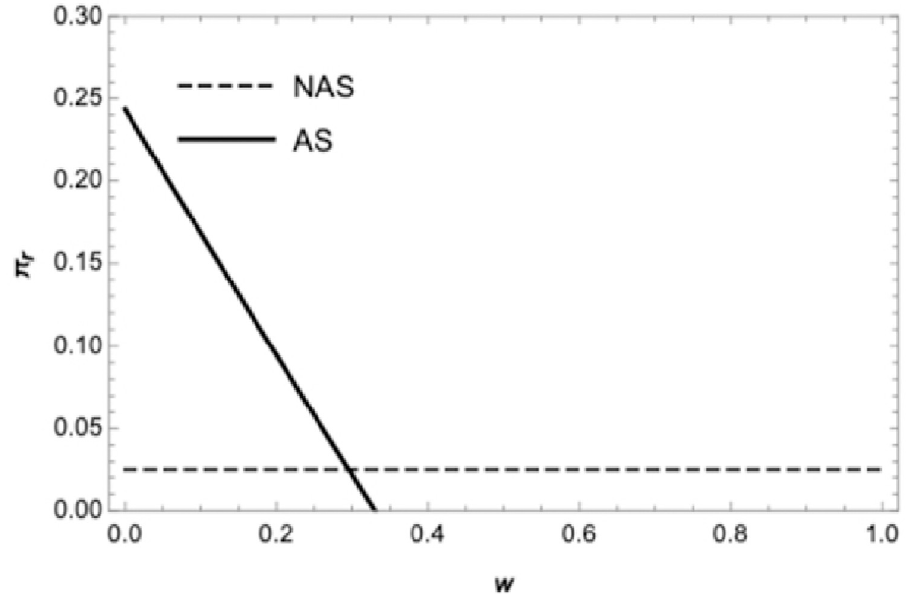
Fig 2. The retailer’s profit in the wholesale price